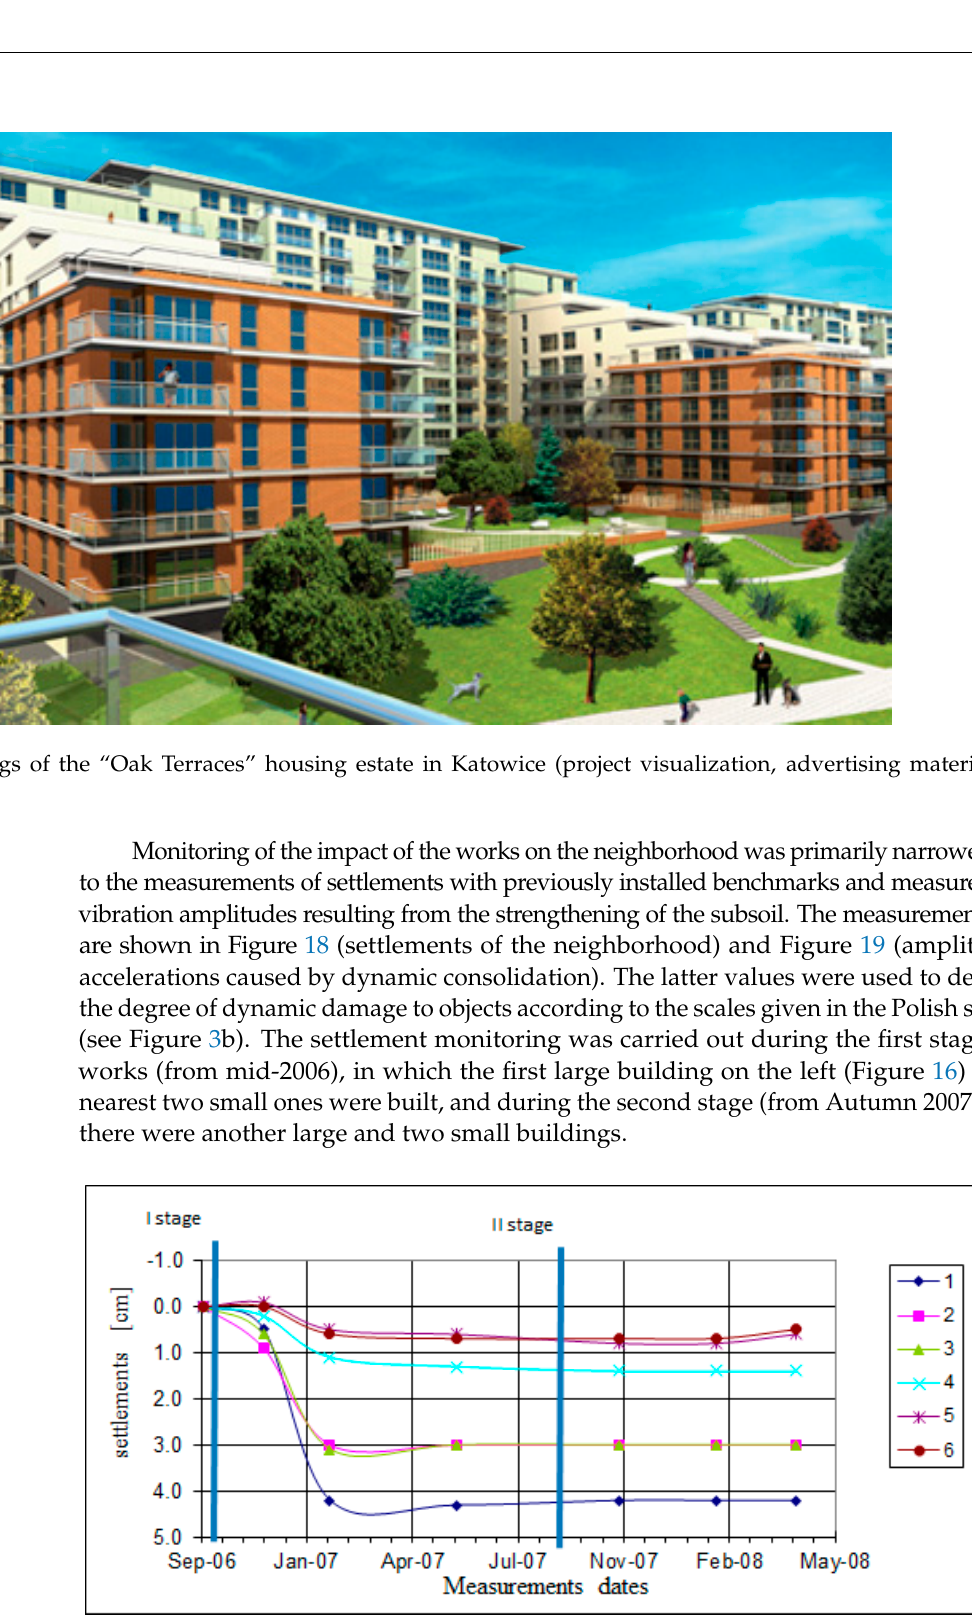
Figure 18. Settlement on selected benchmarks (near the construction site of the “Oak Terraces” housing estate in Katowice).